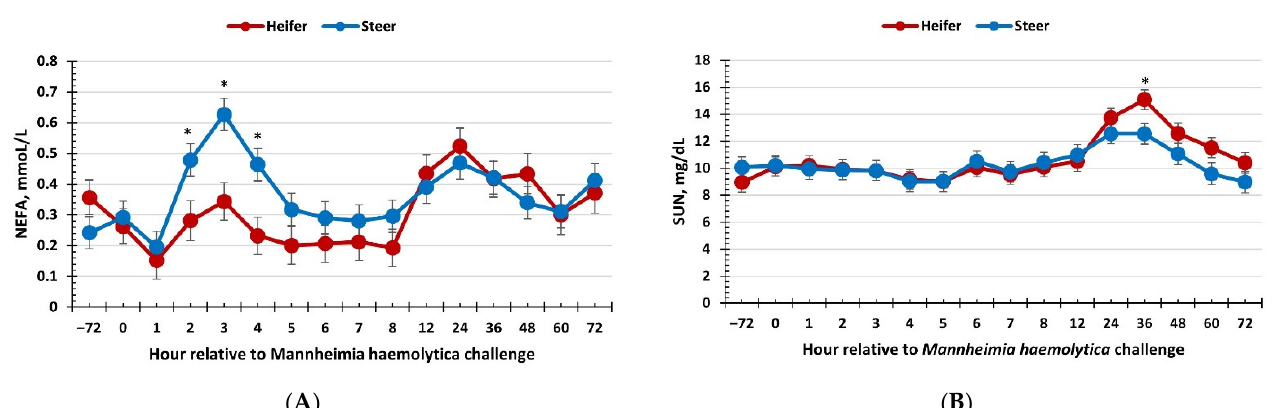
Figure 4. Influence of calf sex on the ( A ) non-esterified fatty acid (NEFA) and ( B ) serum urea nitrogen response to a dual viral–(bovine herpesvirus-1; 1 × 10 8 pfu/nostril) bacterial ( Mannheimia haemolytica ; 1.3 × 10 7 cfu) respiratory disease challenge. ( A ) There was a sex × time interaction ( p < 0.01) for NEFA concentrations where heifers had reduced concentrations from 2 to 4 h post-challenge relative to steers. ( B ) A sex × time interaction ( p < 0.01) was observed for serum urea nitrogen concentrations such that heifers had greater concentrations at 36 h and tended to have greater concentrations at 60 h compared to steers. * Sexes differ p ≤ 0.02.